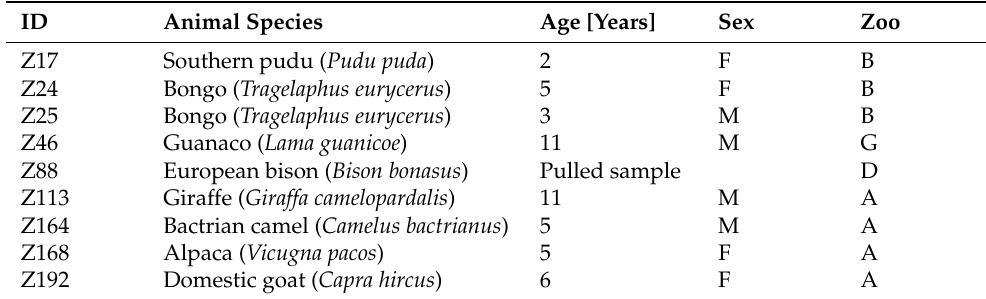
Table 3. Animals positive for IS900 in